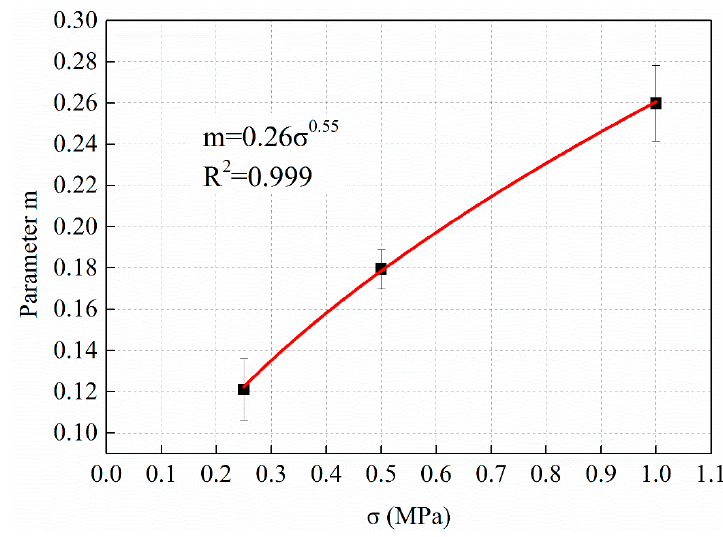
Figure 9. The relationship between dynamic modulus decay parameter m and stress level σ .